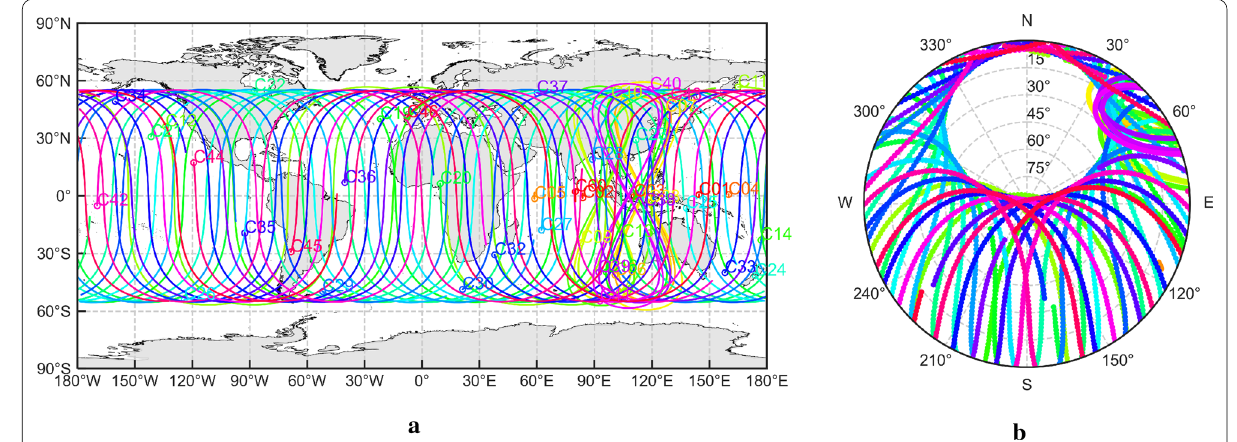
Fig. 1 a Ground tracks of BDS satellites and b the sky plot at an observation site in Nottingham, UK on July 23,